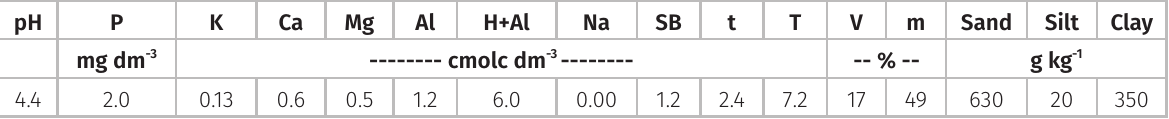
Table I. Chemical and granulometric characterization of soil at depth 0-20 cm. pH P K Ca Mg Al H+Al Na SB t T V m Sand Analyses performed according to EMBRAPA (2017): pH (water); Mehlich -1 extractable P and K; Ca, Mg and Al exchangeable for 1 mol L -1 KCl. Where: H + Al: potential acidity; SB = sum of bases; t = effective cation exchange capacity; T = cation exchange capacity at ph 7; V = base saturation; m = aluminum saturation. We used samples composed of 10 simple samples collected in the experimental